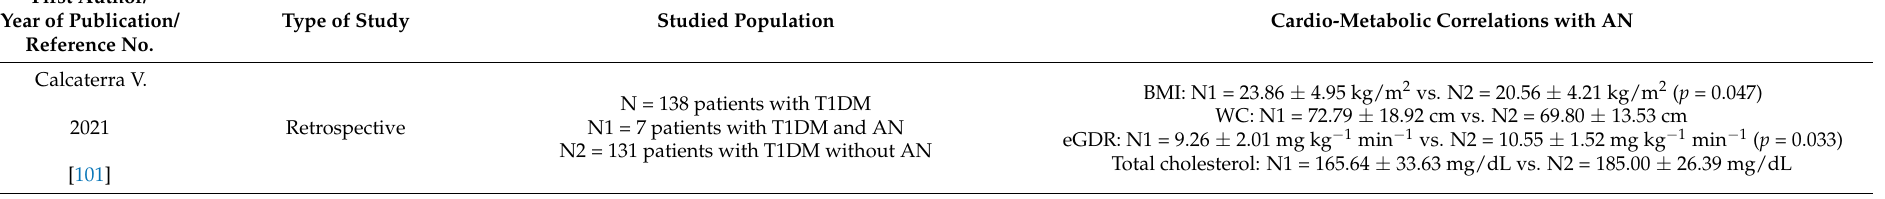
Table 2. Studies within the last 5 years concerning AN and DM (the order of display is from 2022 to 2017) (please see references no.